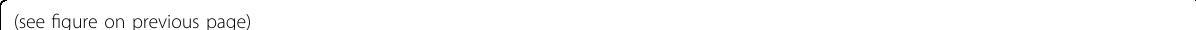
Fig. 2 Enhanced memory formation in Nr2f6 − / − CD8 + T cells is cell-intrinsic. A Schematic overview of adoptive cell transfer of naïve CD45.2 +